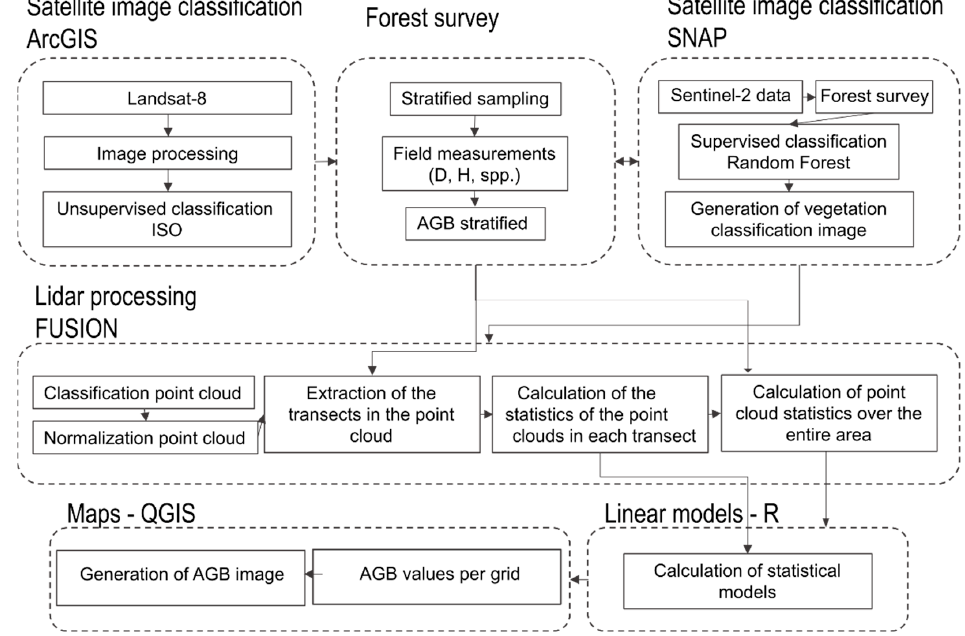
Figure 3. Workflow of the vegetation classification and lidar-based AGB estimation model.